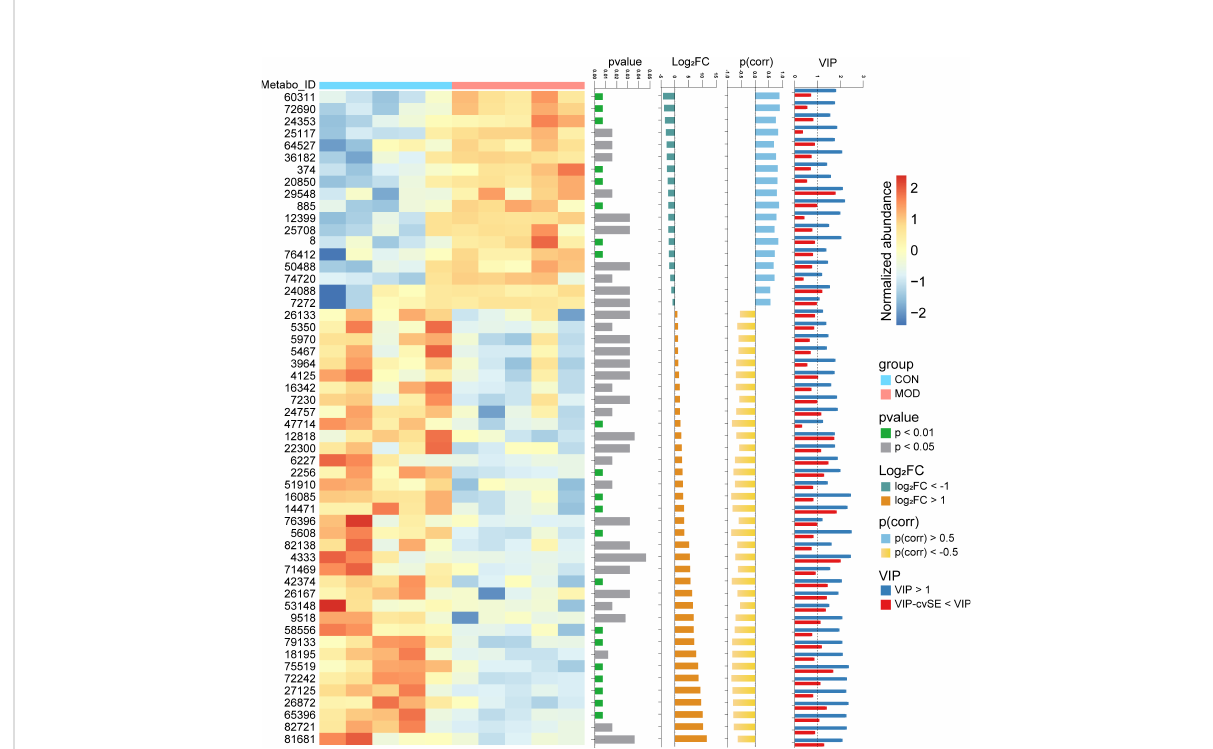
FIGURE 6 Metabolome analysis of duodenum. Differential metabolites were identi fi ed with thresholds of p < 0.05, |log2(FC)| > 1, |p(corr)| > 0.5 and VIP > 1 with cvSE of VIP less than the VIP value ( n = 5 rats/group). The compound names corresponding to the Metabo_ID from top to bottom are as follows. 60311: Glycolithocholic acid; 72690: Taurolithocholate; 24353: Decanoyl-L-carnitine; 25117: Sphingosine; 64527: Glycodeoxycholic acid; 36182: Arachidonyl Ethanolamide; 374: Tyramine; 20850: C17 Sphingosine; 29548: Taurocholic acid; 885: Benzyl sulfate; 12399: Myristoyl Ethanolamide; 25708: Sphinganine; 8: 3-Hydroxybutyric acid; 76412: Taurodeoxycholate; 50488: Palmitoylcarnitine; 74720: Tricaprylin; 24088: Phytosphingosine; 7272: N,N-Dimethyltetradecylamine; 26133: 7-Sulfocholic acid; 5350: FA 18:2+O; 5970: Eicosapentaenoic acid; 5467: 9- HODE; 3964: gamma-Linolenic acid; 4125: Linoleic acid; 16342: Cholic acid; 7230: FA 18:2+2O; 24757: LPE(18:2/0:0); 47714: 7-Ketolithocholic acid; 12818: Lithocholic acid; 22300: Andrastin C; 6227: Arachidonic acid; 2256: Biotin; 51910: 6,7-Diketolithocholic acid; 16085: 3-Oxocholic acid; 14471: Murocholic acid; 76396: Taurochenodeoxycholate; 5608: FA 18:1+1O; 82138: LPC(18:1/0:0); 4333: Oleic acid; 71469: LPE(18:1/0:0); 42374: 3-Ketocholanic Acid; 26167: Oleoyl Ethanolamide; 53148: Hyocholic acid; 9518: N,N-Dimethyltetradecylamine-N-oxide; 58556: Stearoyl-L-Carnitine; 79133: LPC(17:0/0:0); 18195: Palmitoleoyl Ethanolamide; 75519: LPC(16:0/0:0); 72242: LPC(15:0/0:0); 27125: Docosahexaenoic acid; 26872: Stearoyl Ethanolamide; 65396: LPE(16:0/0:0); 82721: LPC(18:0/0:0); 81681: